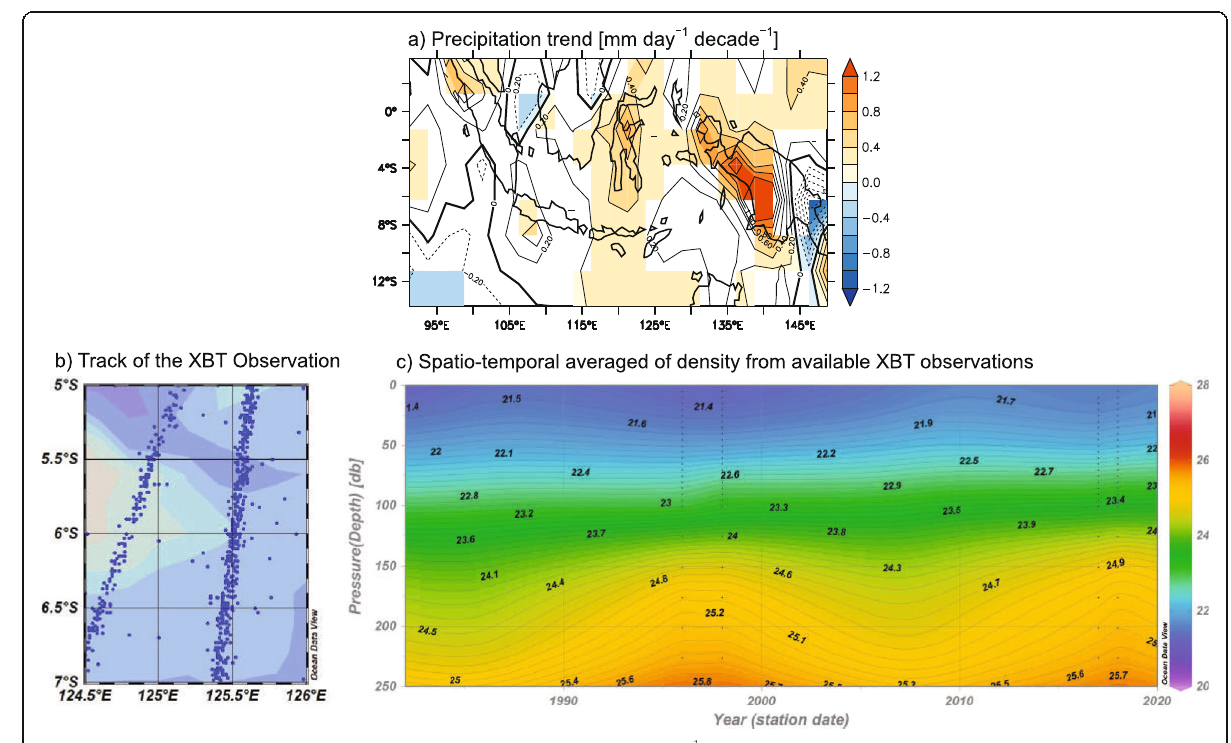
Fig. 4 a Observed trend in precipitation over the period of 1982 – 2013 (mm day − 1 /decade). b Location of available observed CTD, XCTD, and XBT data from WOD 2018, and c averaged vertical density profiles derived from temperature and salinity data of selected WOD 2018